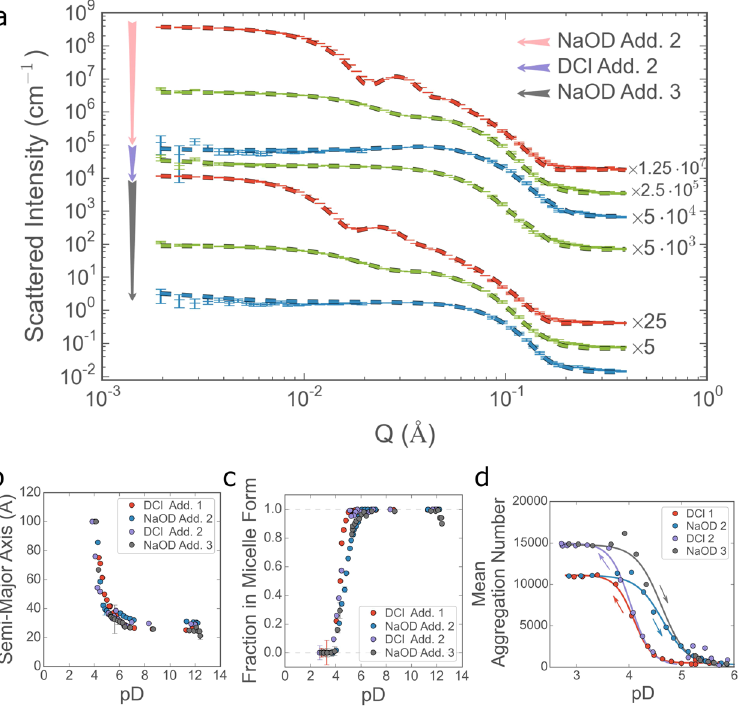
Figure 6. ( a ) Representative azimuthally averaged intensity profiles vs Q from the multiple titrations of DCl and NaOD. The dashed lines are fits of the model described in the text. All profiles with an adjacent number have been shifted in intensity for clarity. The colours correspond to the similar pD values: red ≈ 2.9, green ≈ 4.9, blue ≈ 11.7. Data are represented by thin horizontal lines with error bars and fits are shown as thick dashed lines. Plots ( b – d ) show the evolution of the fitted parameters with pD: ( b ) semi-major axis of the ellipsoidal micelles, ( c ) volume fraction of micelles and ( d ) mean aggregation number of the self-assembled aggregates at low pD. The solid lines and arrows in (d) are given as a guide for the